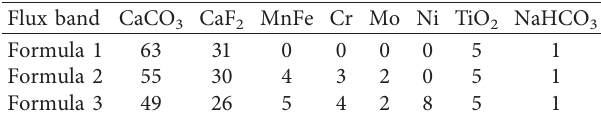
Table 2: Chemical composition of flux band